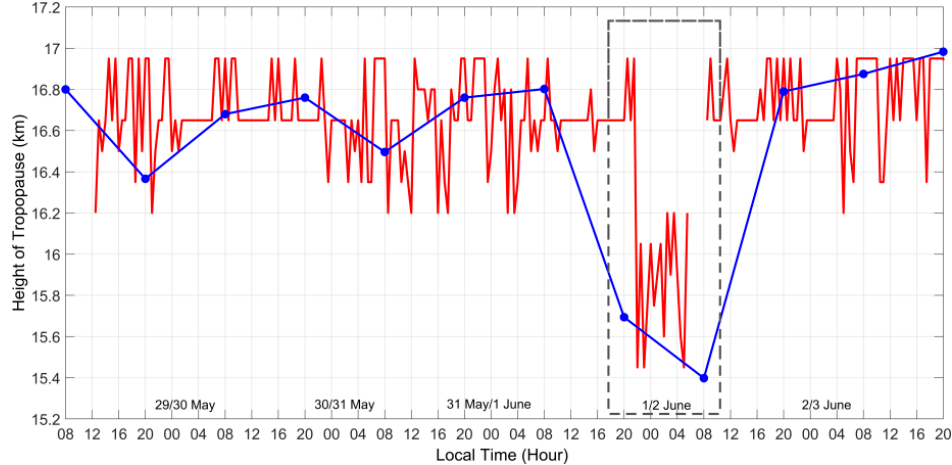
Figure 6. Comparison of the tropopause height variations measured by the Wuhan radiosonde (blue curve) and the Wuhan MST radar (red curve). The gray box highlights the tropopause descent measured by the two systems.